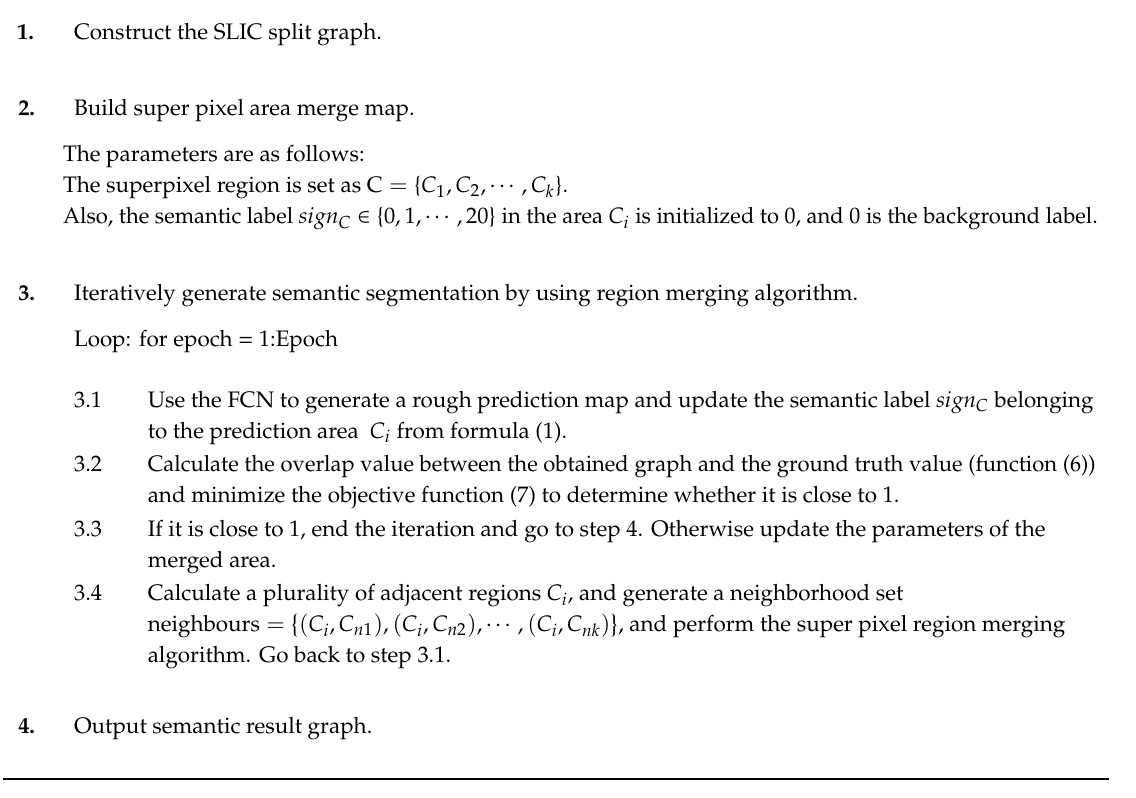
Figure 7. Semantic segmentation graph of different iteration times. The number of iterations is epoch #1, epoch #4, epoch #8, and epoch